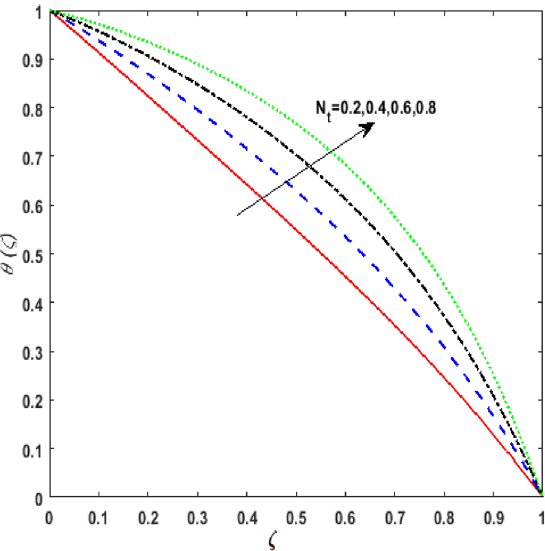
Figure 7. Effect of thermophoresis parameter N t on temperature θ(ζ) .